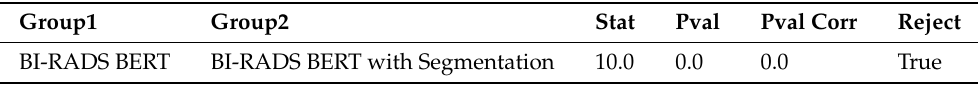
Table A26. McNemar test results for field extraction of